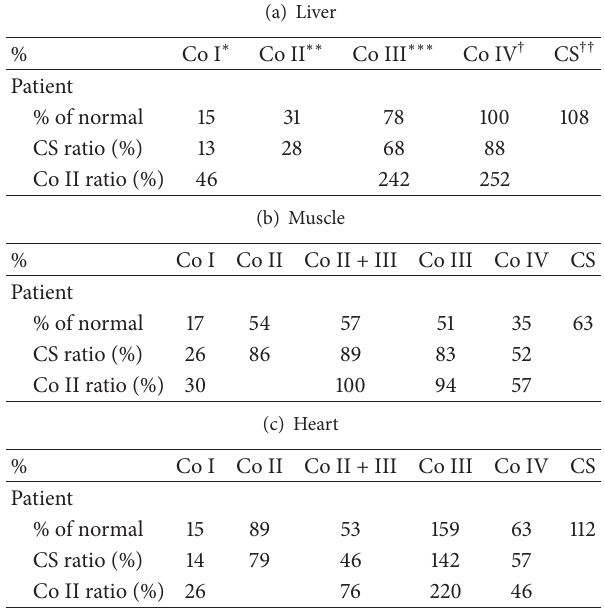
Table 2: Enzyme assay of the mitochondrial respiratory chain (I– IV).